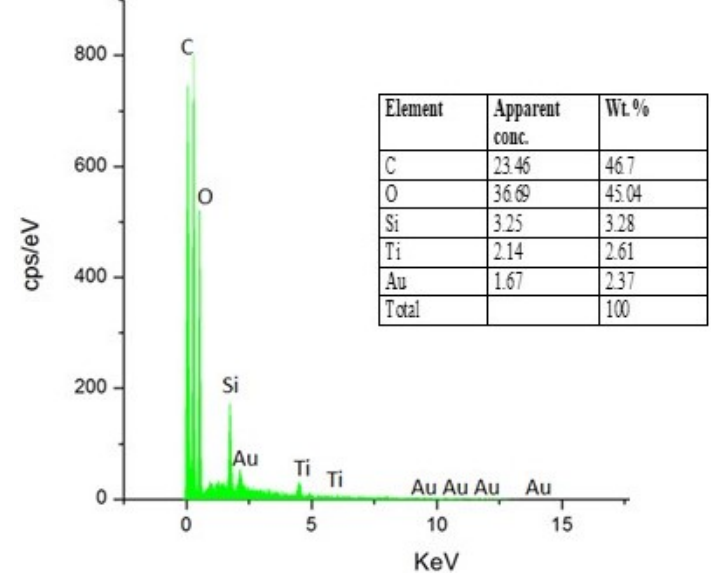
Figure 3. EDX spectra of cotton fabric treated with functionalized nano titania.